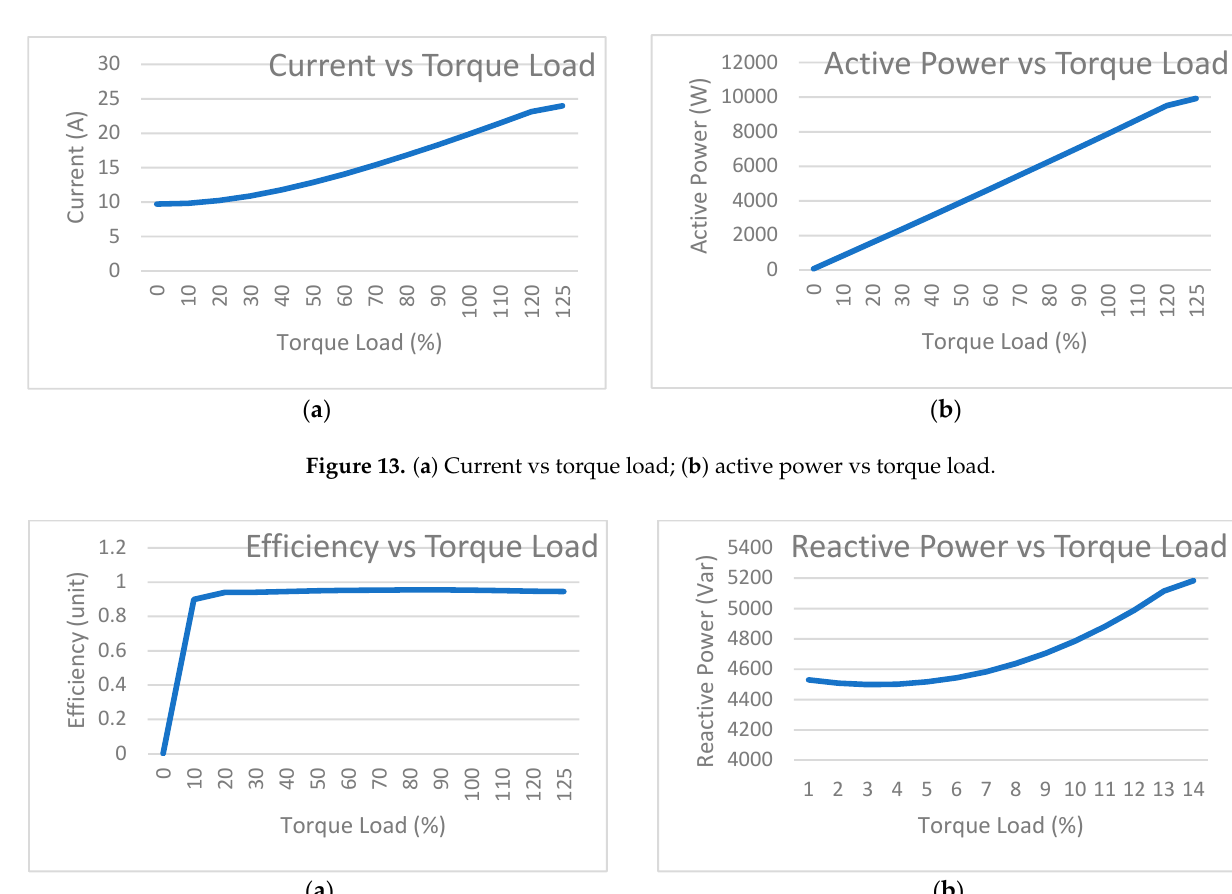
Figure 14. ( a ) Efficiency vs torque load; ( b ) reactive power vs torque load.